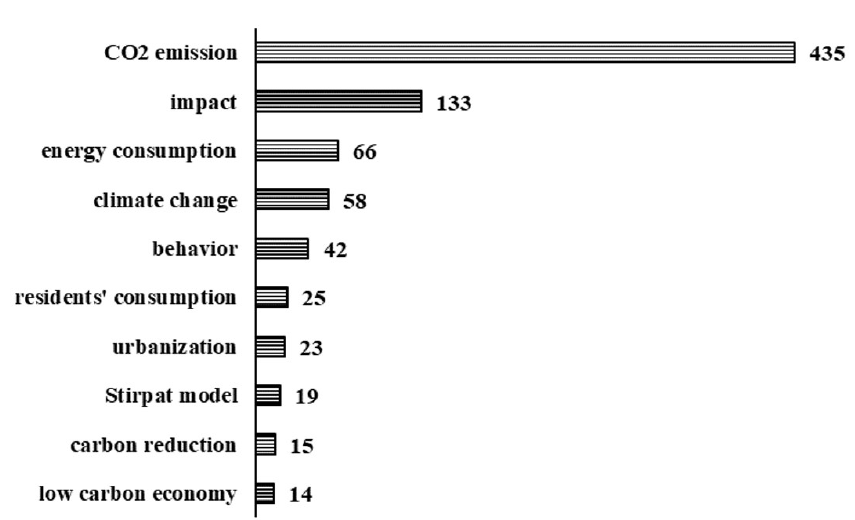
Figure 5. The frequency of keywords in publications. Table 2. Cluster analysis of keywords.